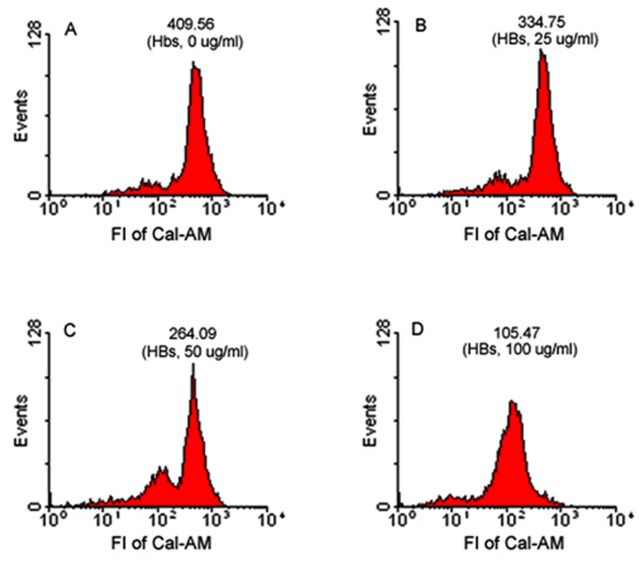
HBs induced MPTP activation in human spermatozoa.The histograms of the number of events (Y-axis) versus the FI (X-axis) in the individual experiment showed that FI of Cal-AM in spermatozoa declined with increasing concentration of HBs, and the number of spermatozoa showing diminished FI rose with increasing concentration of HBs. The change in FI Cal-AM in spermatozoa between panels indicates the continuous activation of MPTP.